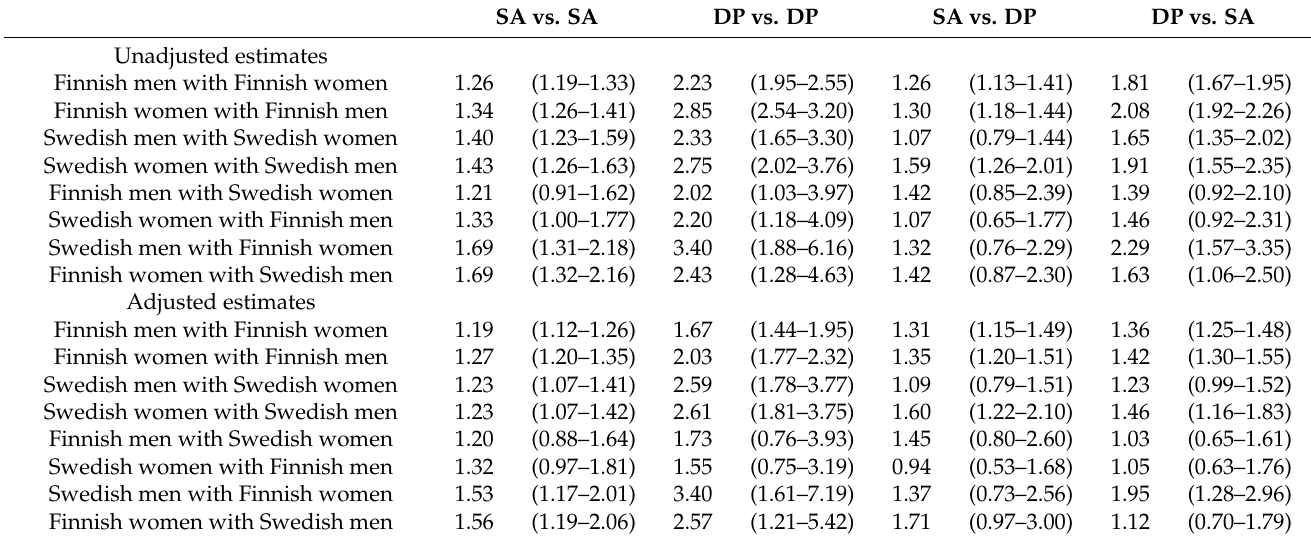
Table 3. Risk of benefit receipt in relation to partner’s receipt, by type of benefit, sex of the study person and ethnolinguistic composition of the household, unadjusted and adjusted estimates, receipt during same calendar